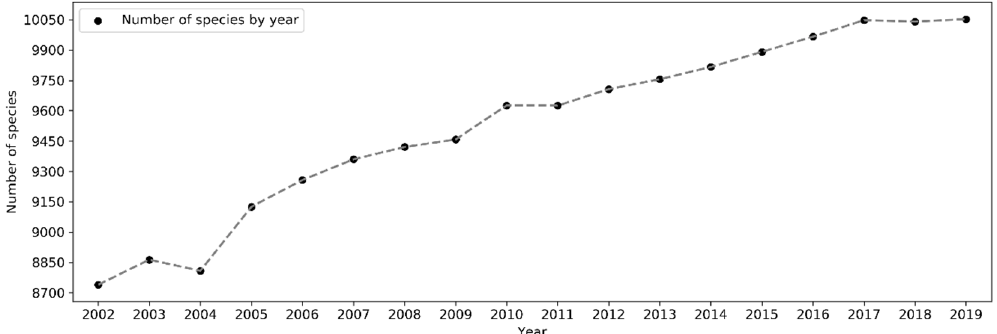
ISPRS Int. J. Geo-Inf. 2020 , 9 , x FOR PEER REVIEW Figure 16. Number of species reported in each year (2002–2019).